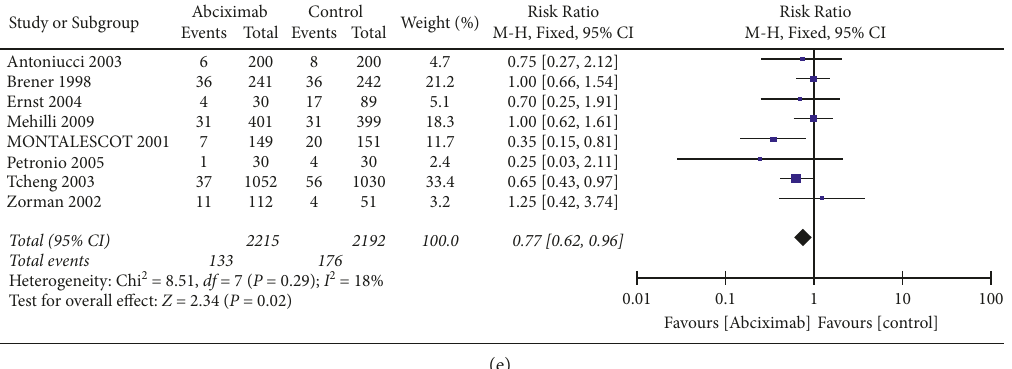
Figure 2: Comparison of primary efficacy outcomes between the abciximab and control groups. (a) All-cause death at 30-day, (b) all-cause death at 6 month, (c) recurrent MI, (d) repeat revascularization, and (e) final TIMI